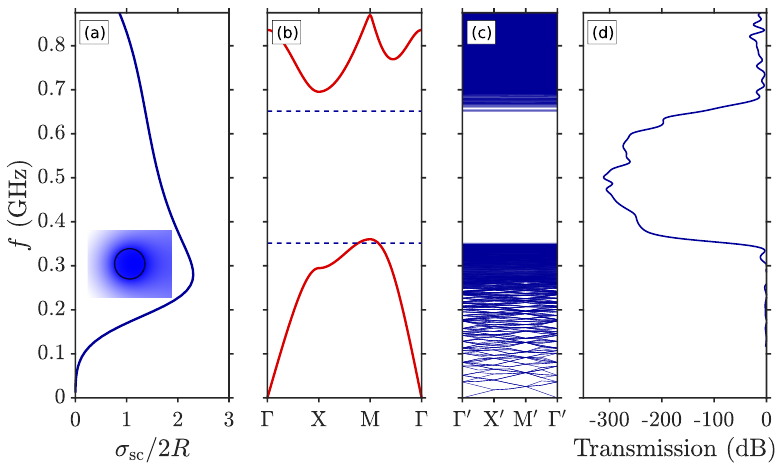
Figure 2. Out-of-plane modes. ( a ) Scattering cross section of a single Pb (infinite) cylinder in epoxy. The z component of the elastic field for excitation from the left with a z -polarized plane wave at 0.28 GHz is shown in the inset (black circle denotes the position of the cylinder). ( b ) The 2D band structure of the periodic crystal of Pb in epoxy. The horizontal broken lines denote the band gap edges of the hyperuniform disordered phononic structures (HDPS). ( c ) The 2D band structure of the HDPS. ( d ) Transmission of the HDPS for a z - polarized incident plane